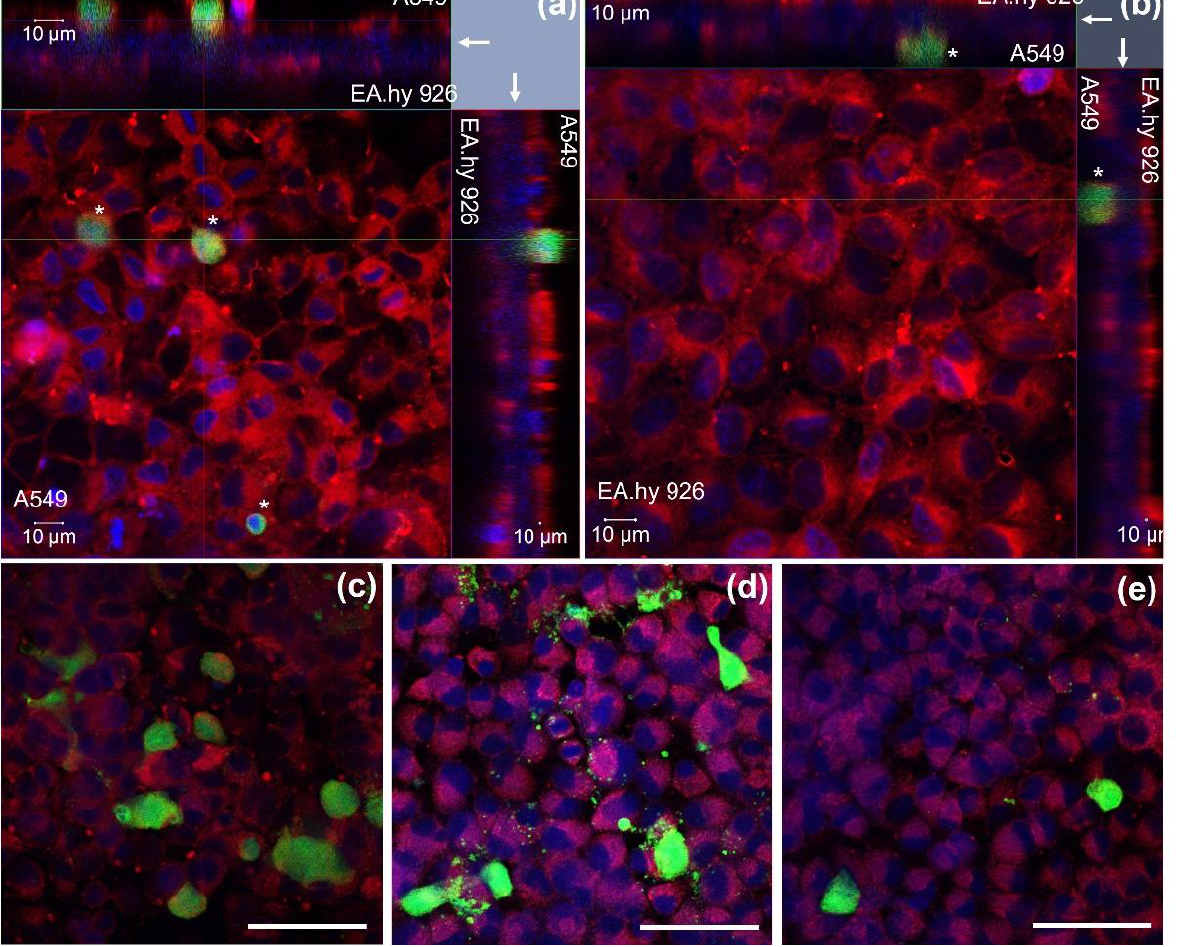
Figure 2. Triculture model investigated by confocal microscopy. ( a , b ) Z-stack image series (2D x-y view and respective side views) showing the distribution of A549, EA.hy926, and dTHP-1 (*, green) cells on the opposite sides of a transwell insert (arrow). ( a ) The 2D x-y view from the A549 and dTHP-1 side (z-stack thickness 44.5 µ m). ( b ) The 2D x-y view from the EA.hy926 side (z-stack thickness 27.5 µ m). ( c – e ) dTHP-1 cells in different morphologies on top of the A549 cells. Red: cellular membranes stained with Cell Mask red dye, blue: nuclei counterstained with DAPI, green: dTHP-1 cells stained with Cell tracker green dye. Magnification: 40 × . Scale bar 10 µ m ( a , b ) and 50 µ m ( c – e ). dTHP-1: differentiated